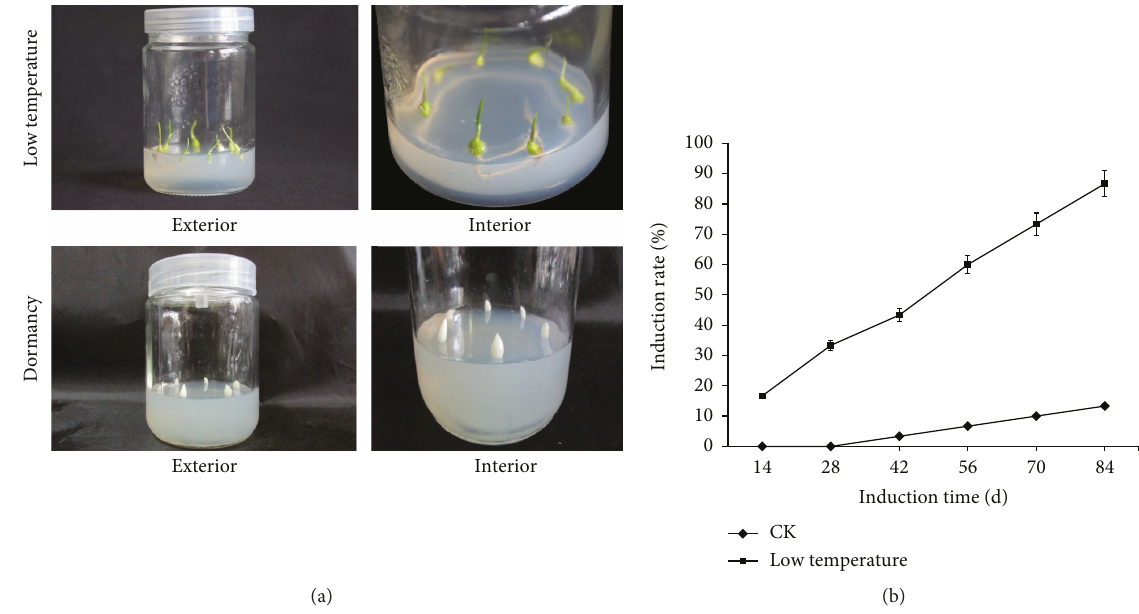
Figure 1: Breaking e ff ect of low-temperature treatment on garlic aerial bulb dormancy. (a) Comparison of germination between aerial bulbs treated and untreated with low temperature after inoculation. (b) Schematic diagram of the germination induction rate of aerial bulbs treated with low